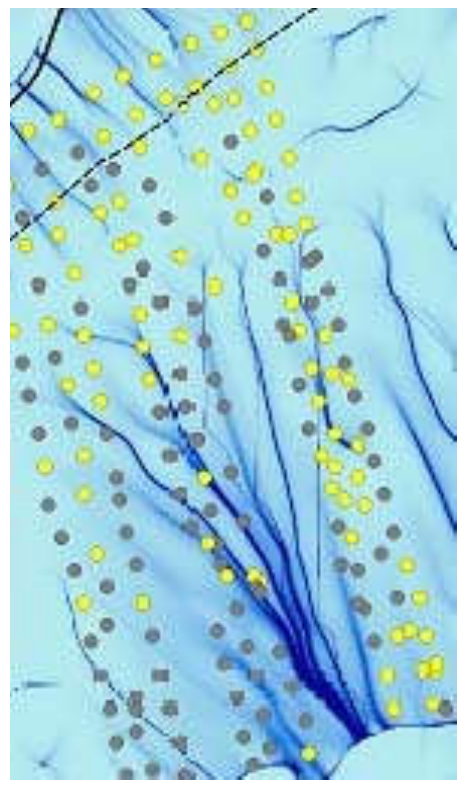
Figure 5 . Humus content at soil sampling points compared to the catchment area map (fragment). Grey markers – above 4% humus content, yellow markers – bellow 4% humus